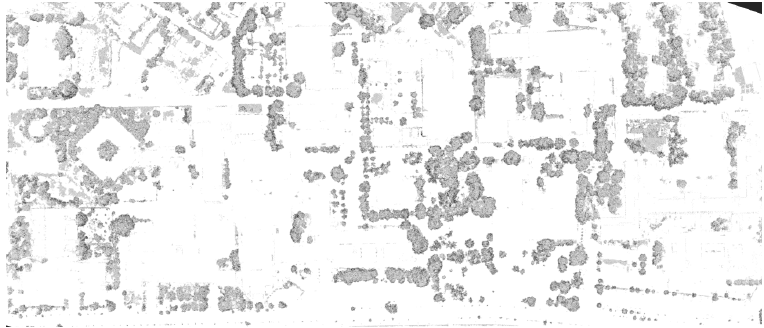
Figure 16. The binary raster for NormalZ attribute values greater than 0.2.